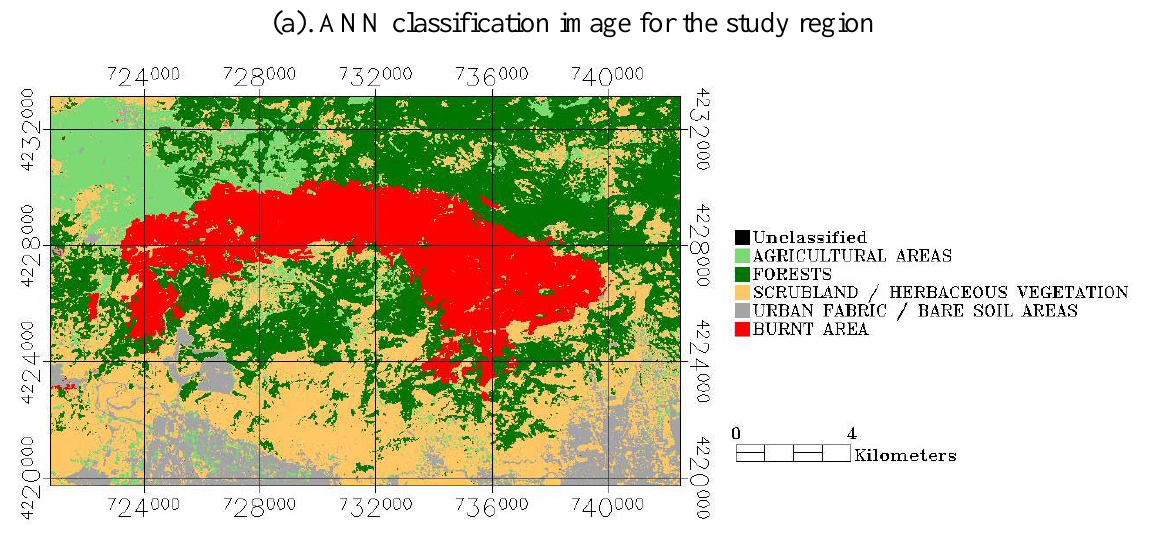
Figure 5. Classification maps obtained from Landsat TM post-fire imagery using ANN (a) and SAM (b)